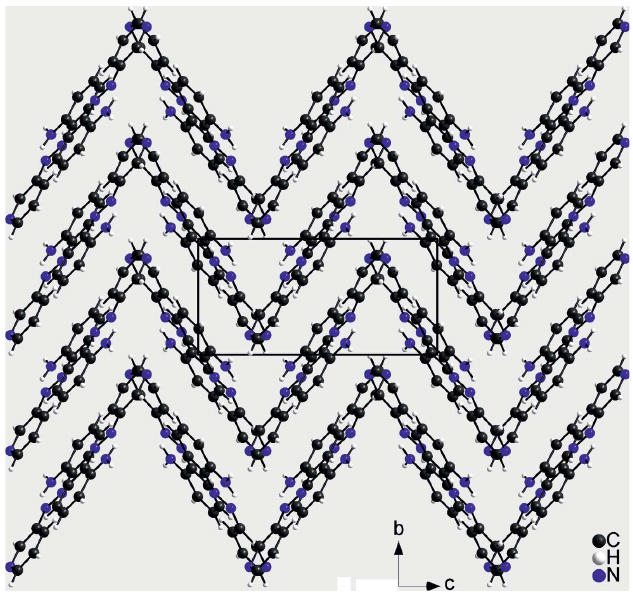
Figure 3 Crystal structure of the title compound in a view along the a axis.